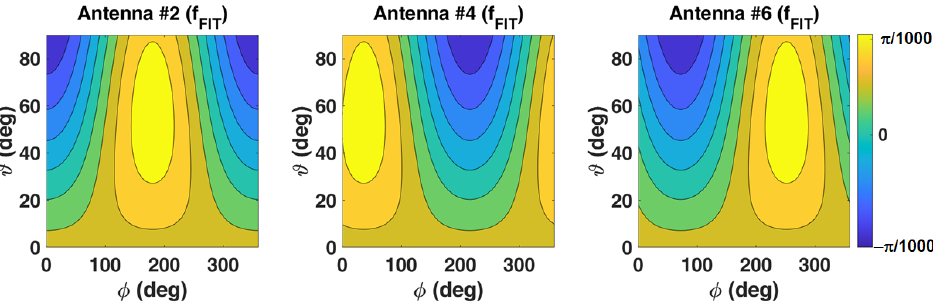
Figure 9. Ideal phase differences respect to reference antenna #1 for frequency fit f FIT = B